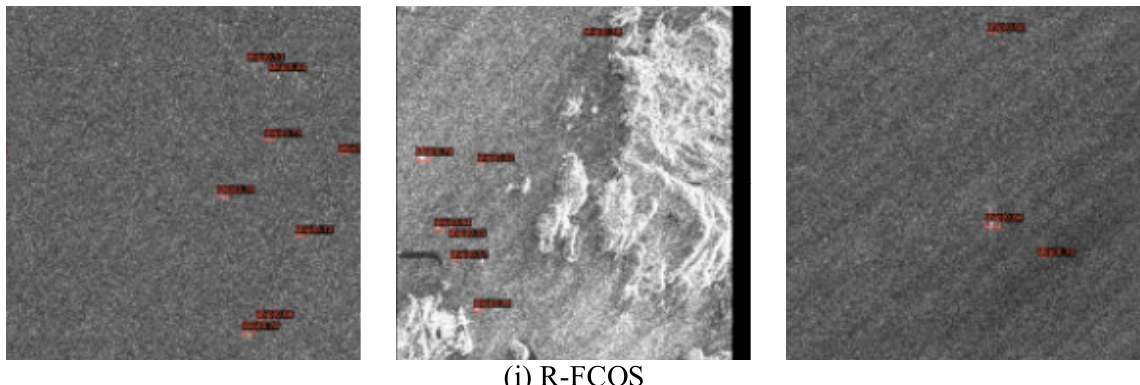
Figure 12. Comparison results of different methods on LS-SSDD-v1.0.